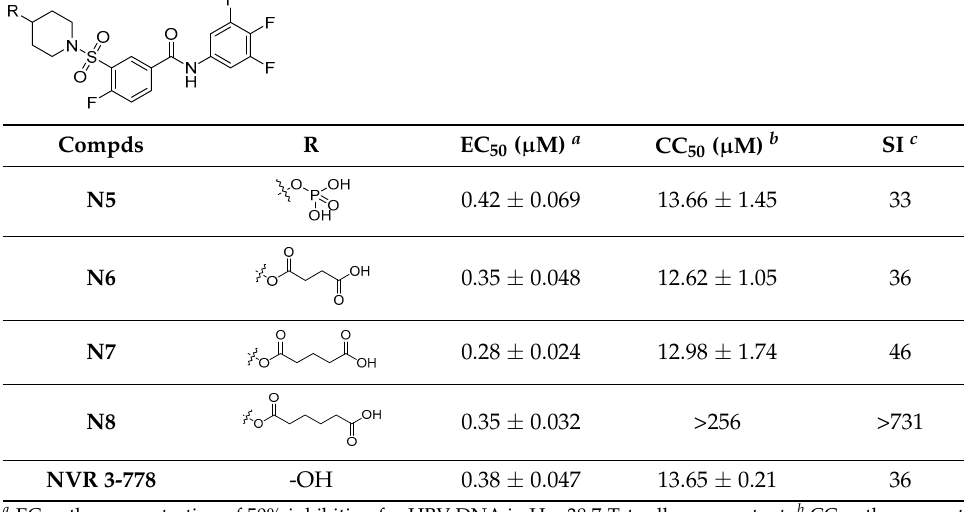
Table 1. Anti-HBV activity and cytotoxicity of the newly synthesized compounds.